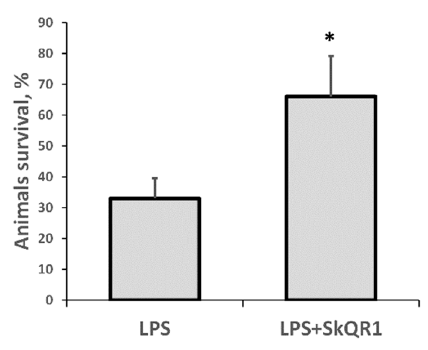
Figure 6. Severe LPS-induced sepsis resulted in high neonatal mortality, which was prevented by SkQR1 treatment. Number of animals in each group was n = 6. * p < 0.05, compared to LPS alone.